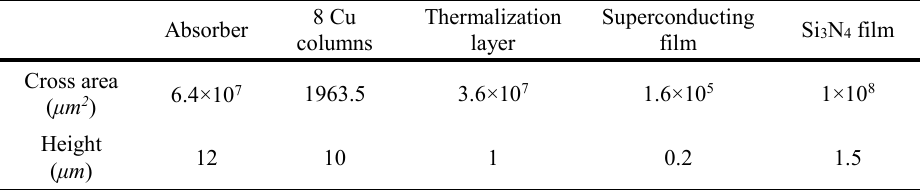
Fig. 2. A schematic drawing of the TES of our design (not to scale). Table 1. The geometric parameters of the TES